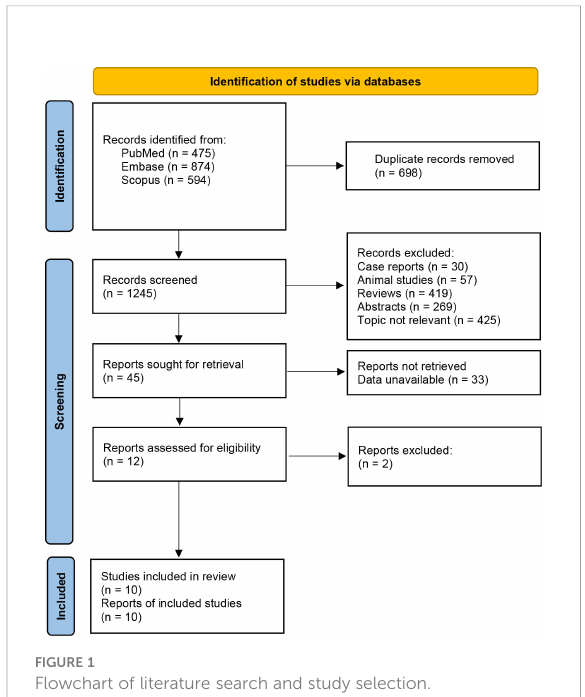
FIGURE 1 Flowchart of literature search and study